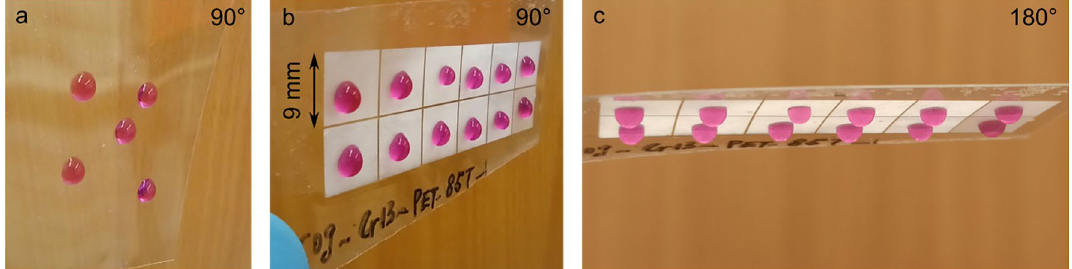
Figure 7. Photographs of water droplets (dyed by 0.1% KMnO 4 solution) on ( a ) a flat and imprinted PET film with a tilting angle of ( b ) ~ 90° and ( c ) ~ 180°. See text for processing parameters of each structured